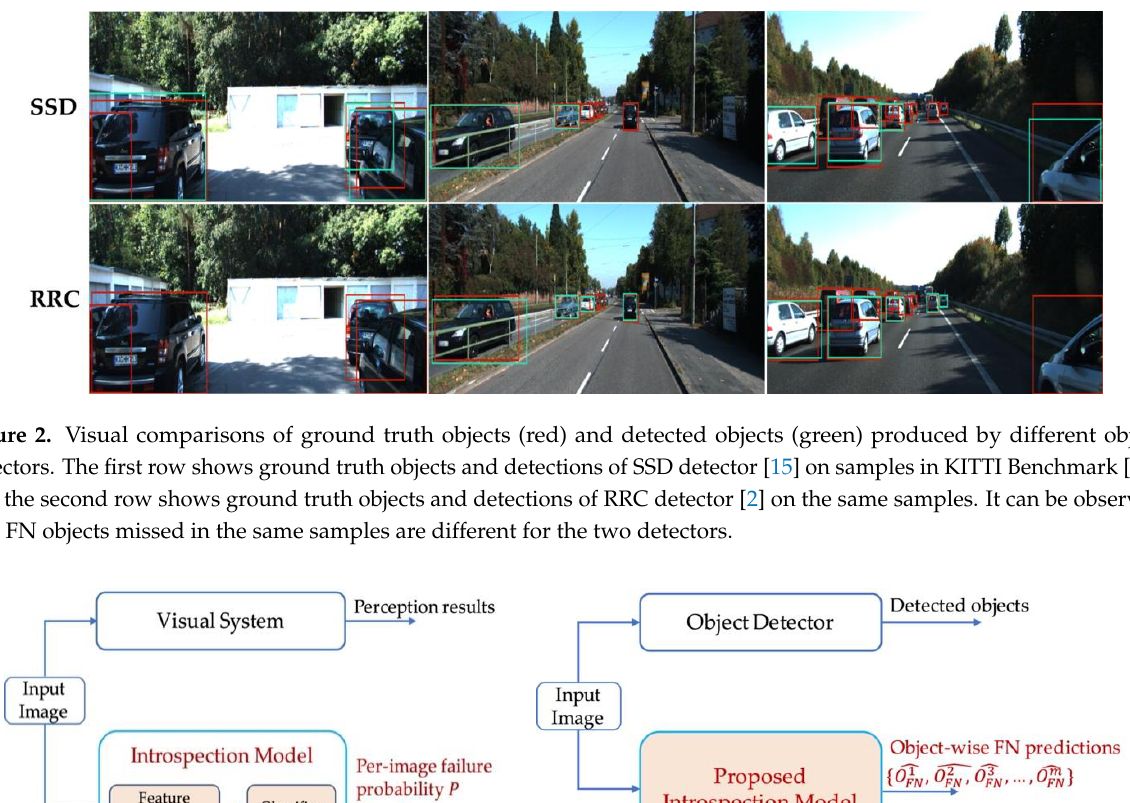
Figure 2. Visual comparisons of ground truth objects (red) and detected objects (green) produced by different object de- tectors. The first row shows ground truth objects and detections of SSD detector [15] on samples in KITTI Benchmark [14], and the second row shows ground truth objects and detections of RRC detector [2] on the same samples. It can be observed that FN objects missed in the same samples are different for the two detectors.